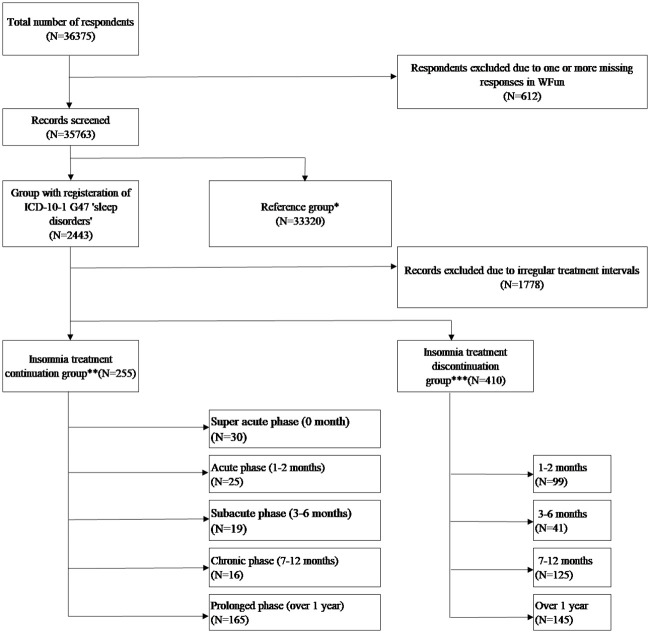
Flow chart for inclusion and exclusion of participants in the study.*ICD-10-1 G47 “Sleep disorders” was not registered in the 16-month observation period. **ICD-10-1 G47 “Sleep disorders” was registered in the 16-month observation period AND Hypnotics were prescribed monthly, once every two months or once every three months and in the month in which the questionnaire response was provided. ***ICD-10-1 G47 “Sleep disorders” was registered in the 16-month observation period AND Hypnotics were prescribed for two consecutive months in the observation period but not in the month in which the questionnaire response was provided.